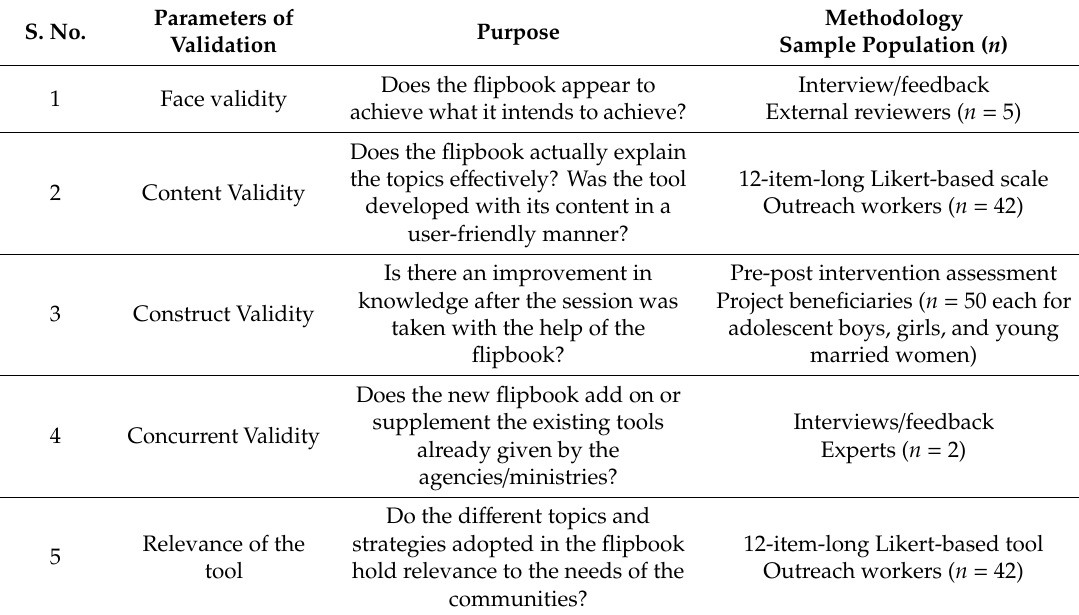
Table 1. Parameters for the validation of flipbooks (information, education, and communication (IEC)